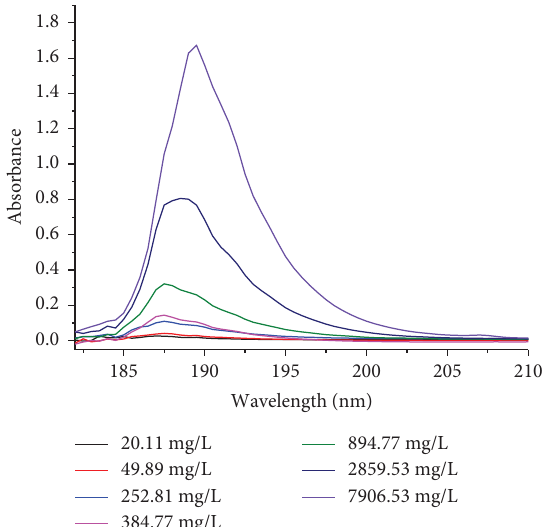
Figure 3: Overlay of absorption spectra of diferent concentrations of the sucrose standard dissolved in water.